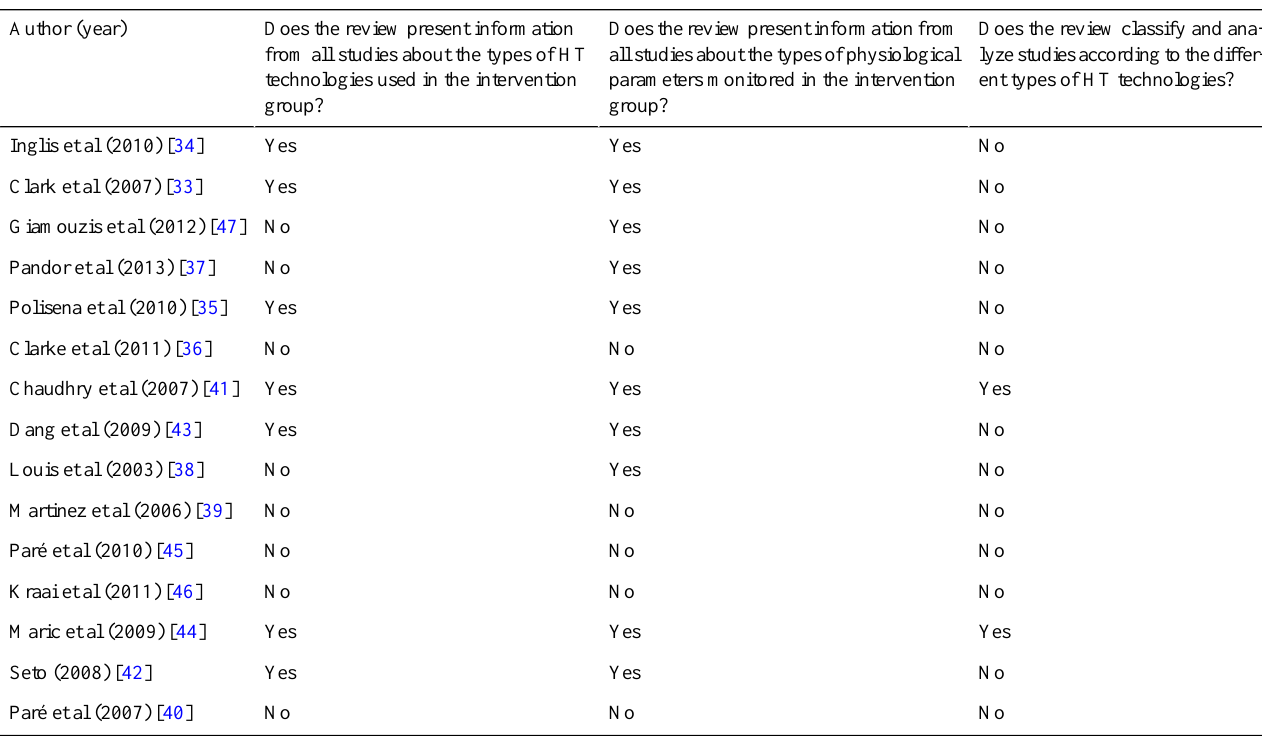
Table 3. Characterization of HT technologies in systematic